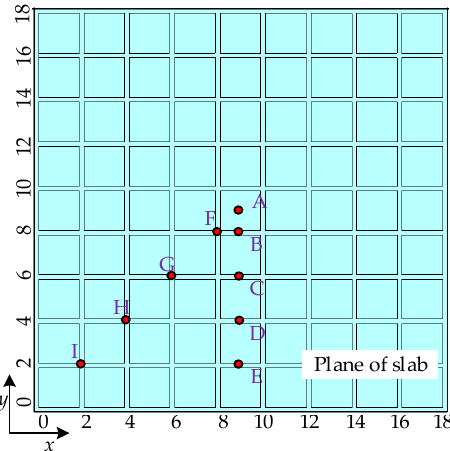
Figure 6. Distribution diagram of points of excitation.